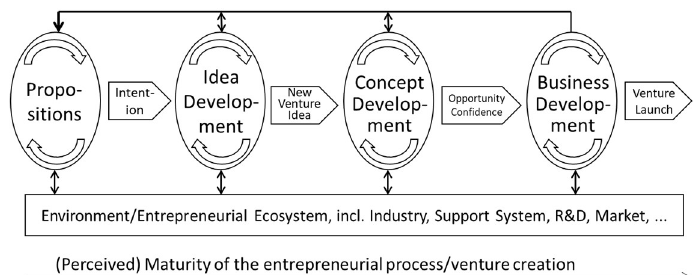
Figure 1. A dynamic stage model of the entrepreneurial process, based on Mets et al. (2019).